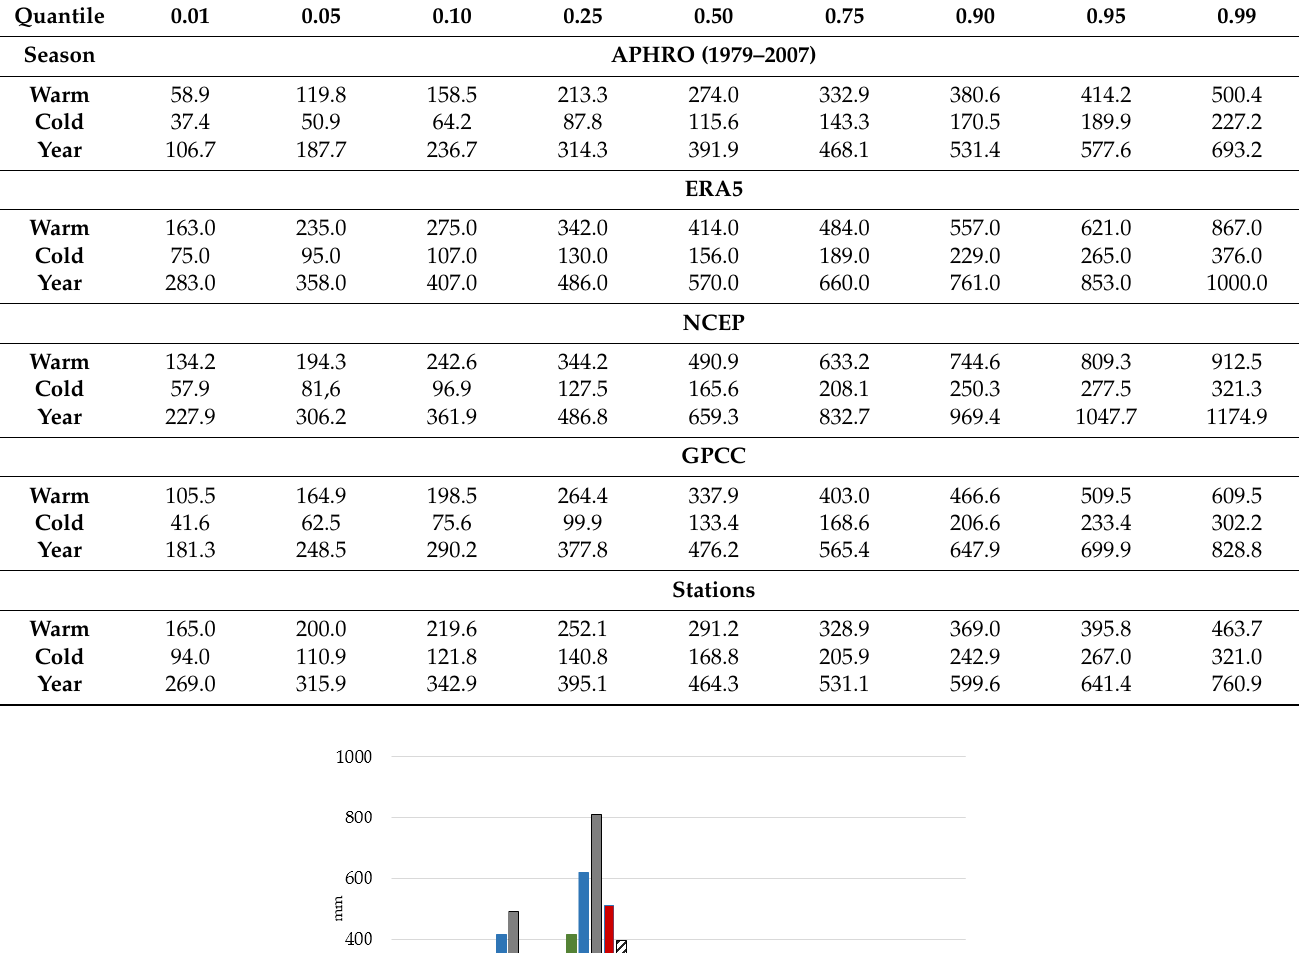
Table 1. The distribution of the precipitation values by the threshold quantiles.